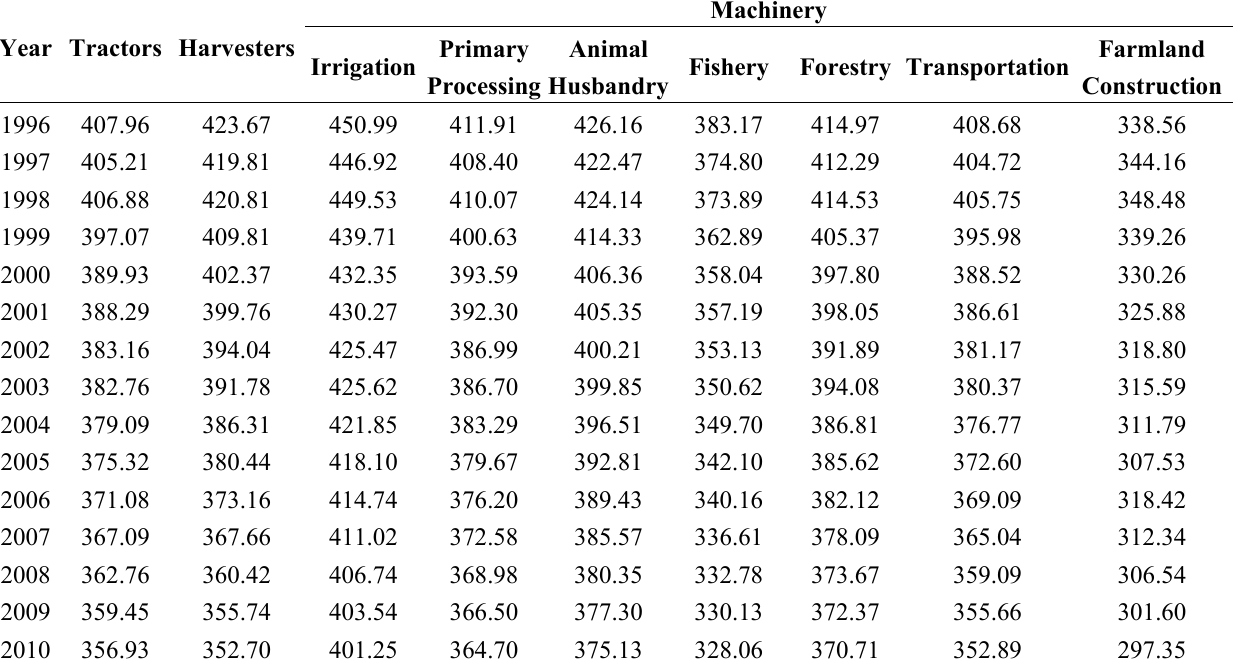
Table 2. Unit diesel consumption (g/kWh) of the agricultural machinery.